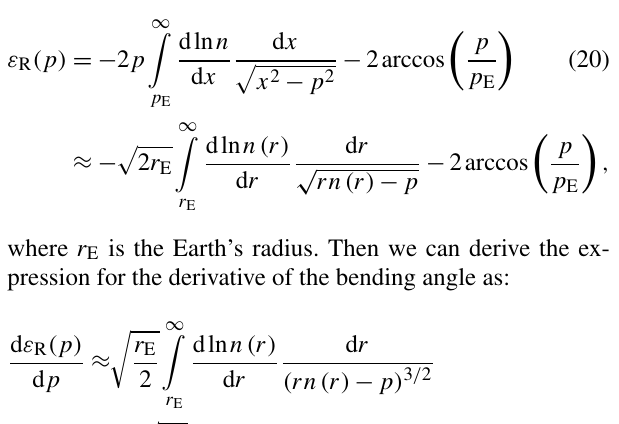
Figure 7. Reflected excess phase model for occultation event 1 Jan- uary 2008, 01:02:23UTC, 70.28 ◦ N 121.87 ◦ W (the same event as in Fig.